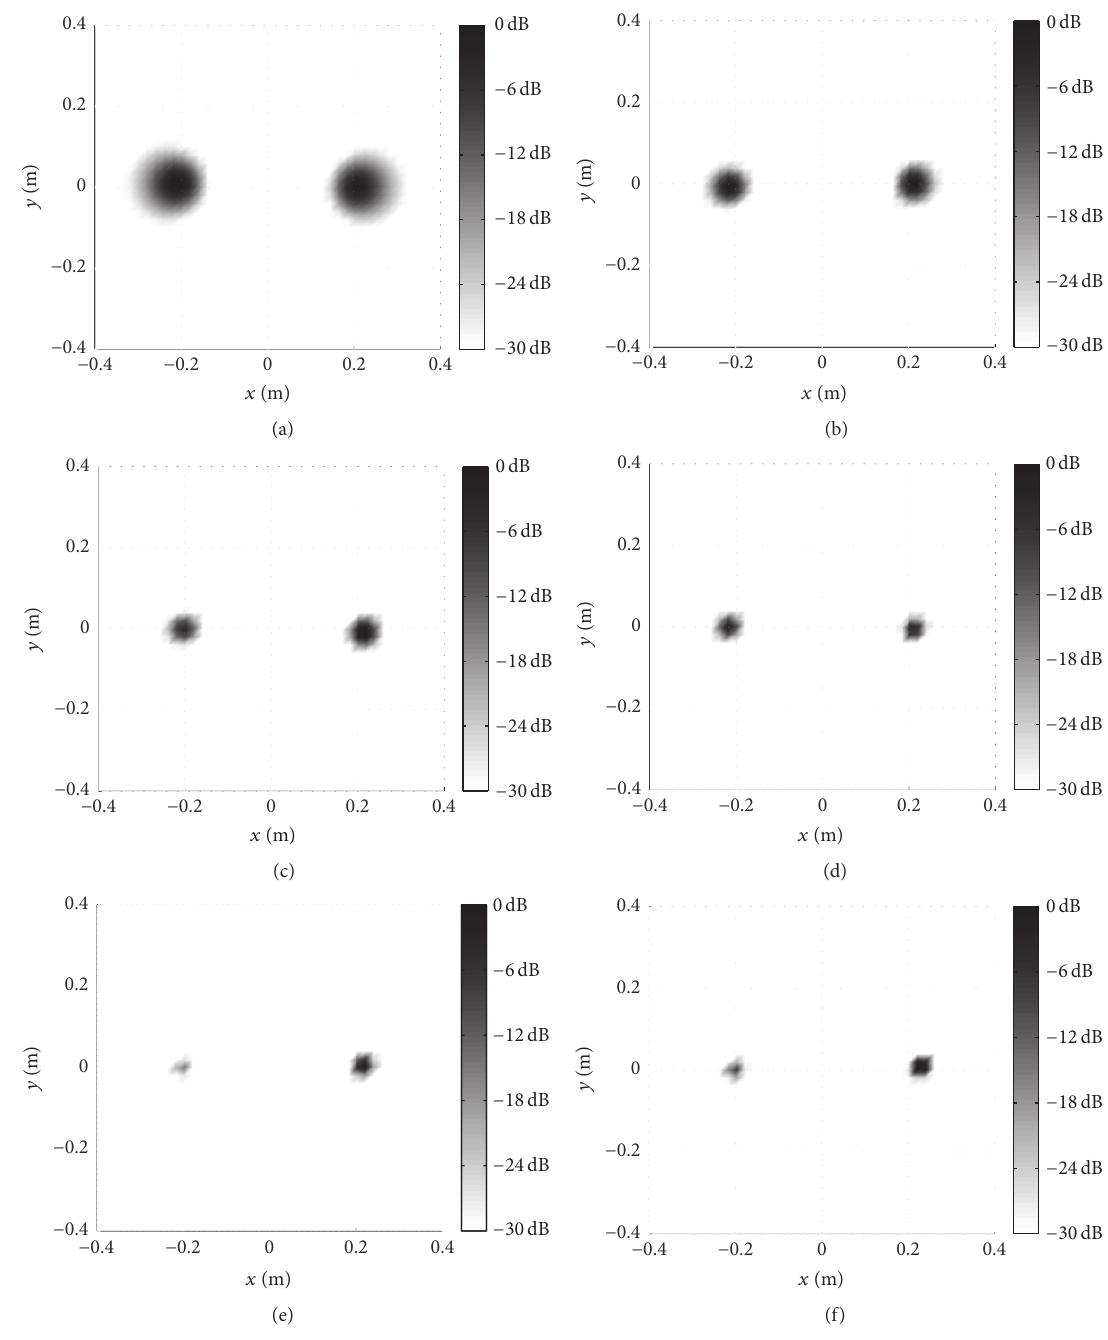
Figure 8: Noise source maps of coherent noise sources (800Hz). (a)–(f) IFESM, V = 1, 3, 5, 8, 10, 12